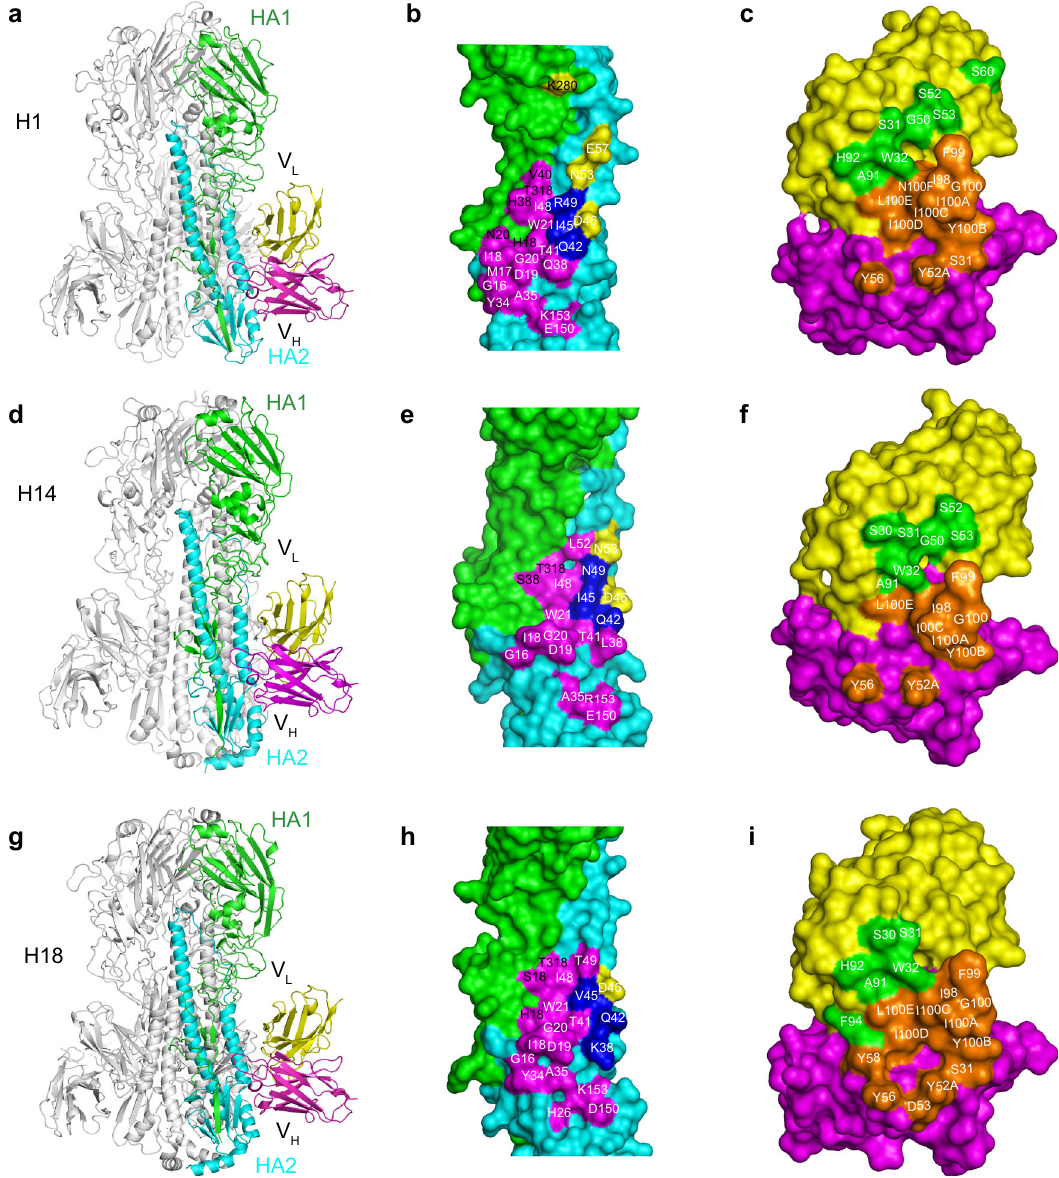
Fig. 3 | Structures of the PN-SIA28/H1, PN-SIA28/H14, and PN-SIA28/H18 com- plexes. The overall structures of the PN-SIA28/H1 ( a ), PN-SIA28/H14 ( d ), and PN- SIA28/H18( g )complexesaredisplayedincartoonrepresentation.ThePN-SIA28Ab bindstheconservedstemregionsoftheH1,H14,andH18HAs.Theepitoperesidues ofPN-SIA28inHA1andHA2ofH1( b ),H14( e ),andH18( h )aredenotedinblackand white characters, respectively. Residues of HA that are in contact with the heavy chain of PN-SIA28 are colored magenta, residues that are in contact with the light